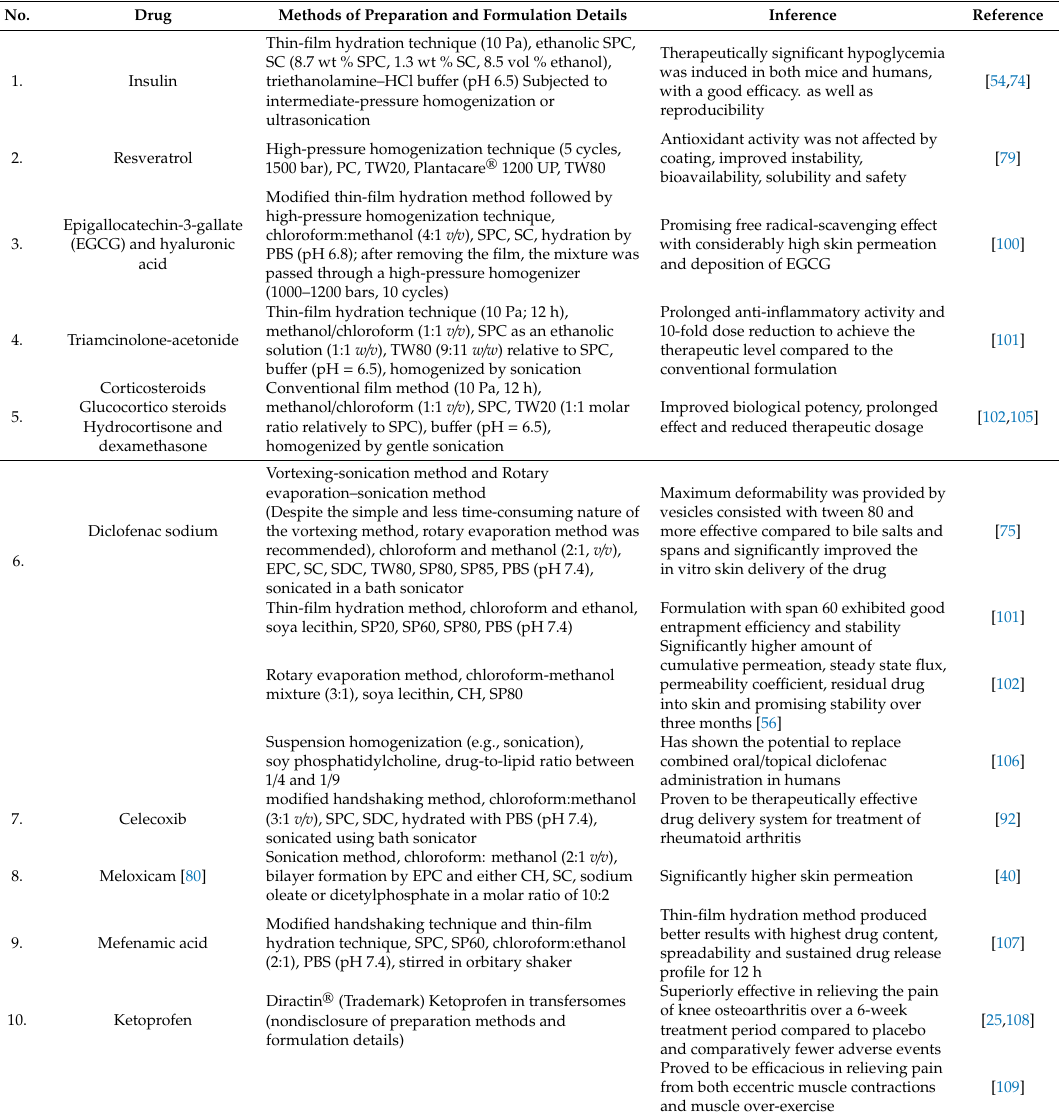
Table 2. Examples of applications of transfersomes as a transdermal delivery